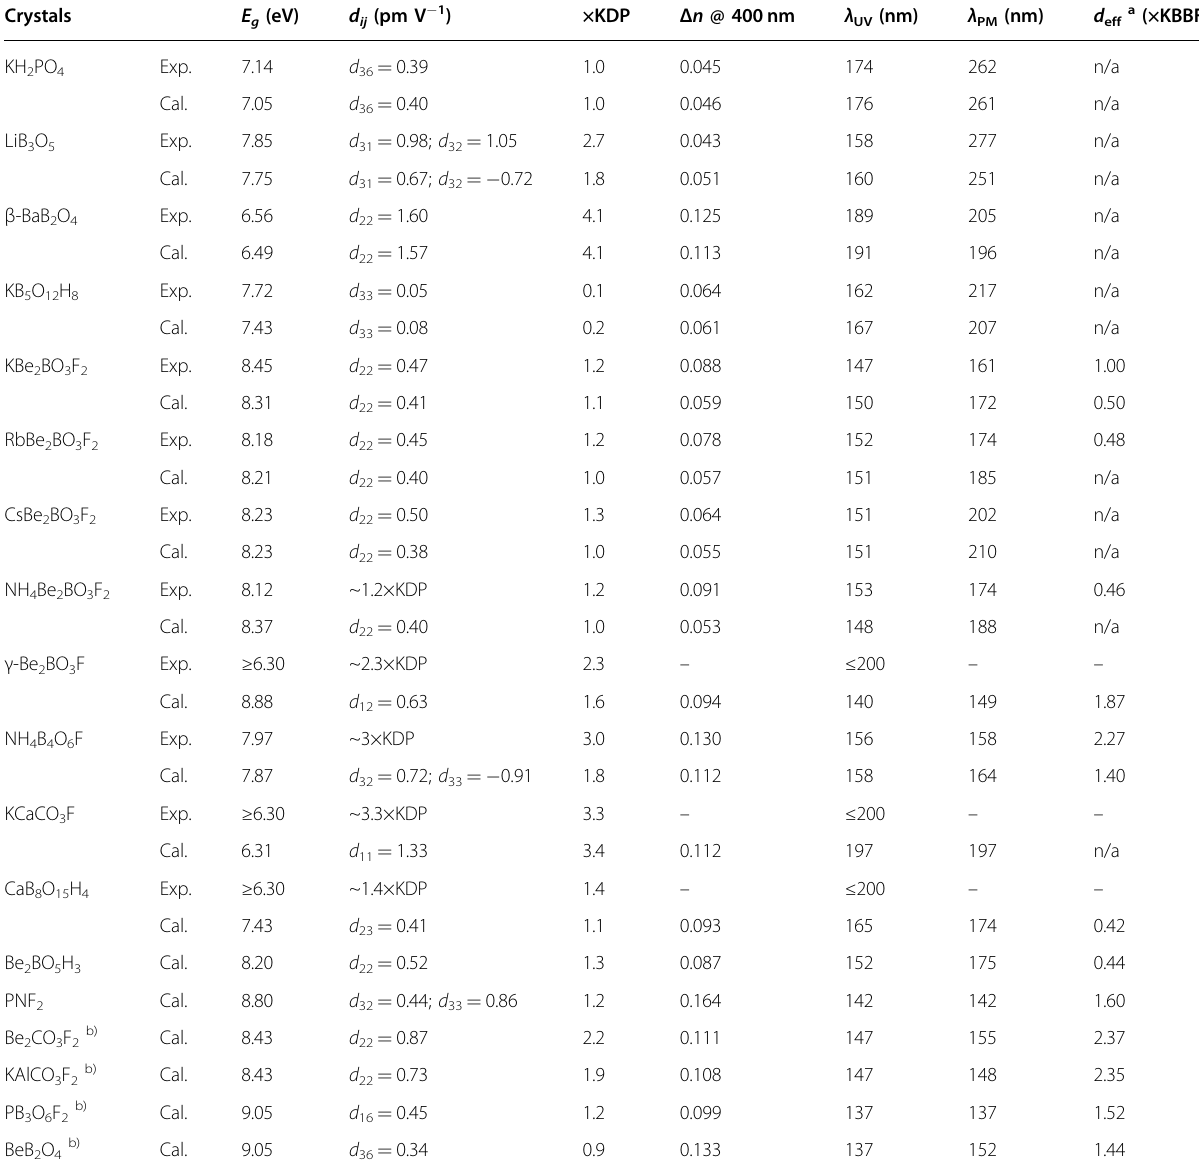
Table 1 Linear and NLO properties of typical UV and DUV NLO crystals